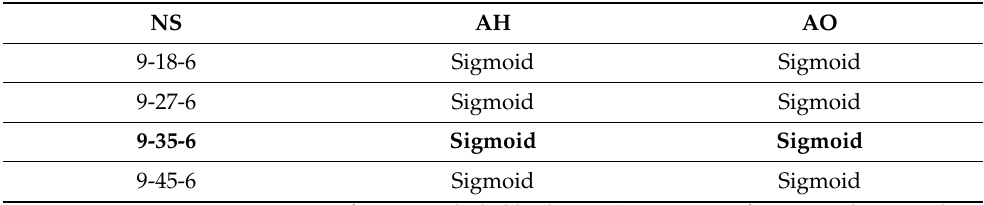
Table 4. The best MLP network models for diagnostic measures (bolded is the best, see also Tables 5 and 6 for more results).